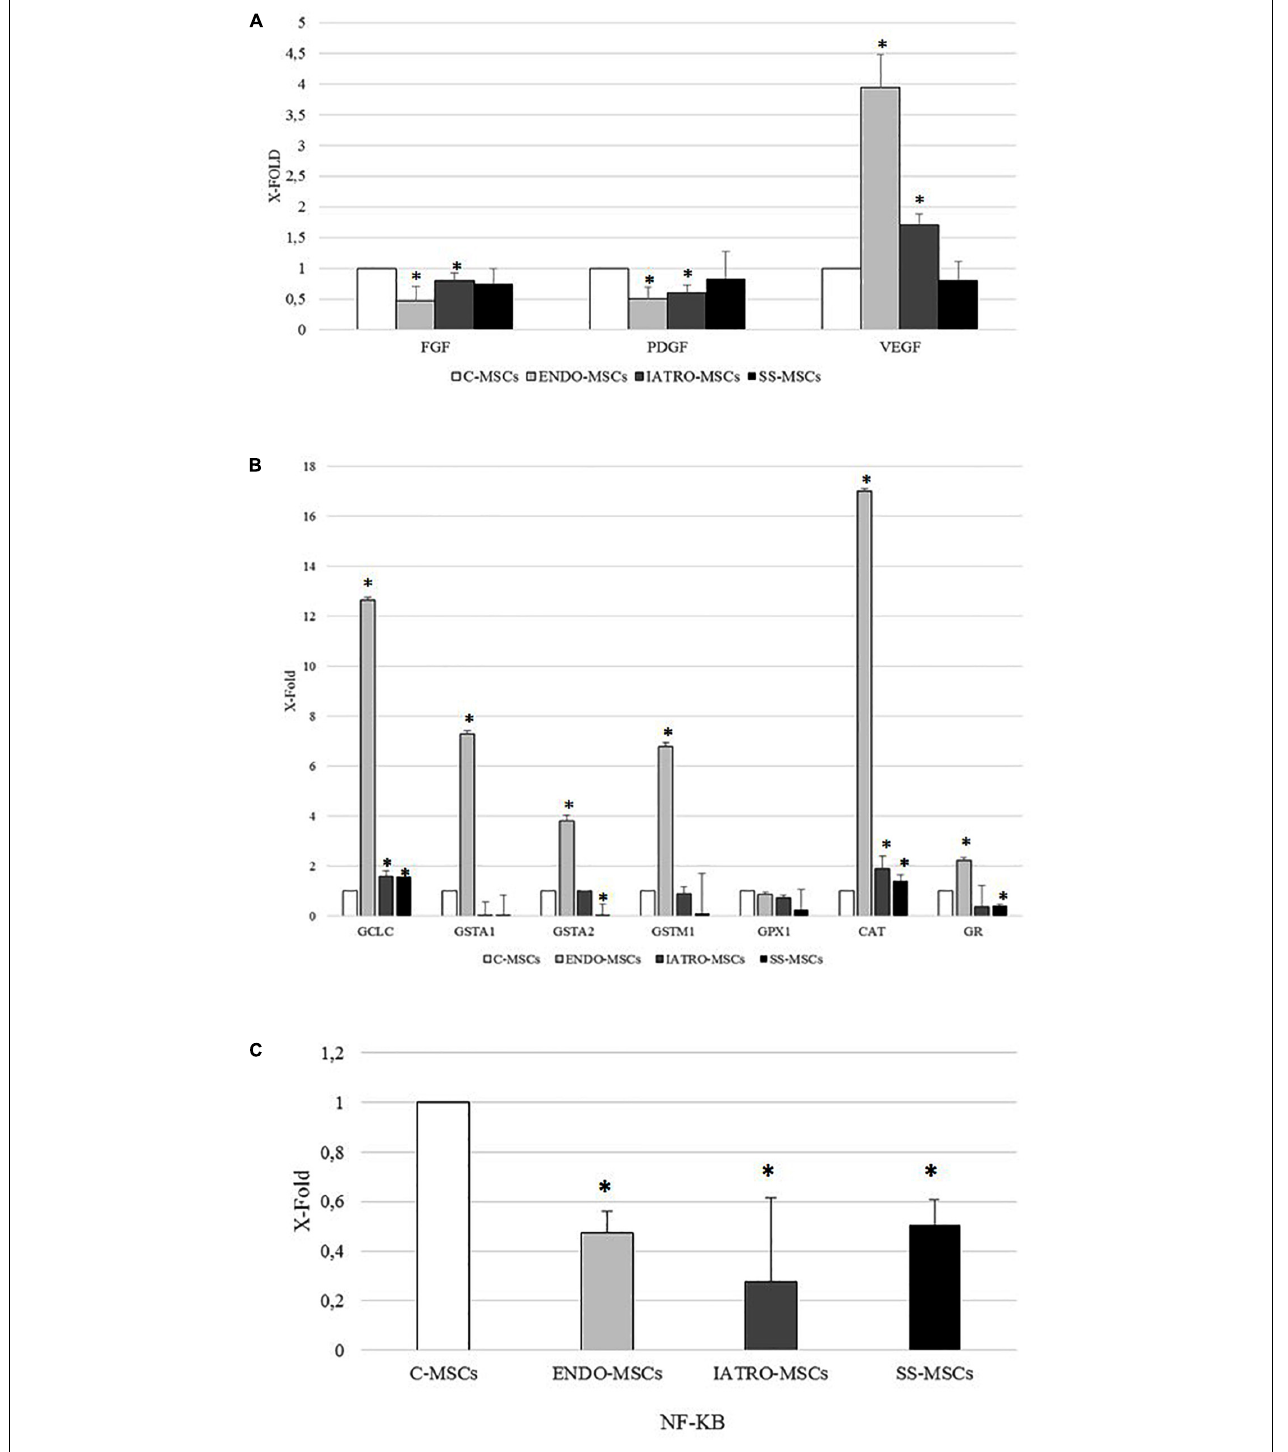
FIGURE 4 | Analysis of the expression of selected genes by RT-PCR. The expression levels measured in MSCs from SC groups are considered as X-fold with respect to C-MSCs (referred as 1). Data are mean ± SD of analyses performed in three different cultures of each group, upon three independent experiments in triplicates. ∗ p < 0.05 MSCs from CS groups vs. C-MSCs. (A) PCR analysis of genes referred to wound healing (FGF: Fibroblast Growth Factor; PDGF: Platelet Derived Growth Factor; VEGF: Vascular Endothelial Growth Factor). (B) PCR analysis of genes referred to antioxidant capacity (GCLC: Glutamate-Cysteine Ligase Catalytic Subunit; GSTA1: Glutathione S-transferase A1; GSTA2: Glutathione S-transferase A2; GSTM1: Glutatione S-transferase mu; GPX1: Glutathione peroxidase 1; CAT: catalase; GR: Glutathione Reductase). (C) PCR analysis of nuclear factor kappa-light-chain-enhancer of activated B cells (NF-KB).